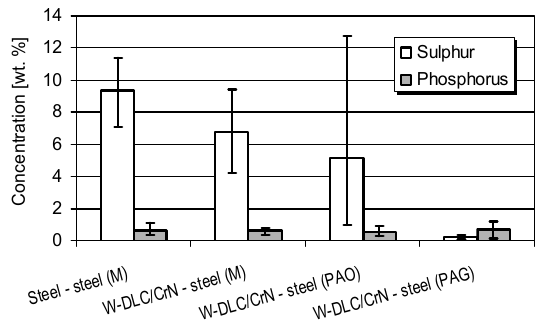
Figure 15. Quantitative results of the EDS analysis of sulfur and phosphorus from the worn surfaces of the vee blocks.